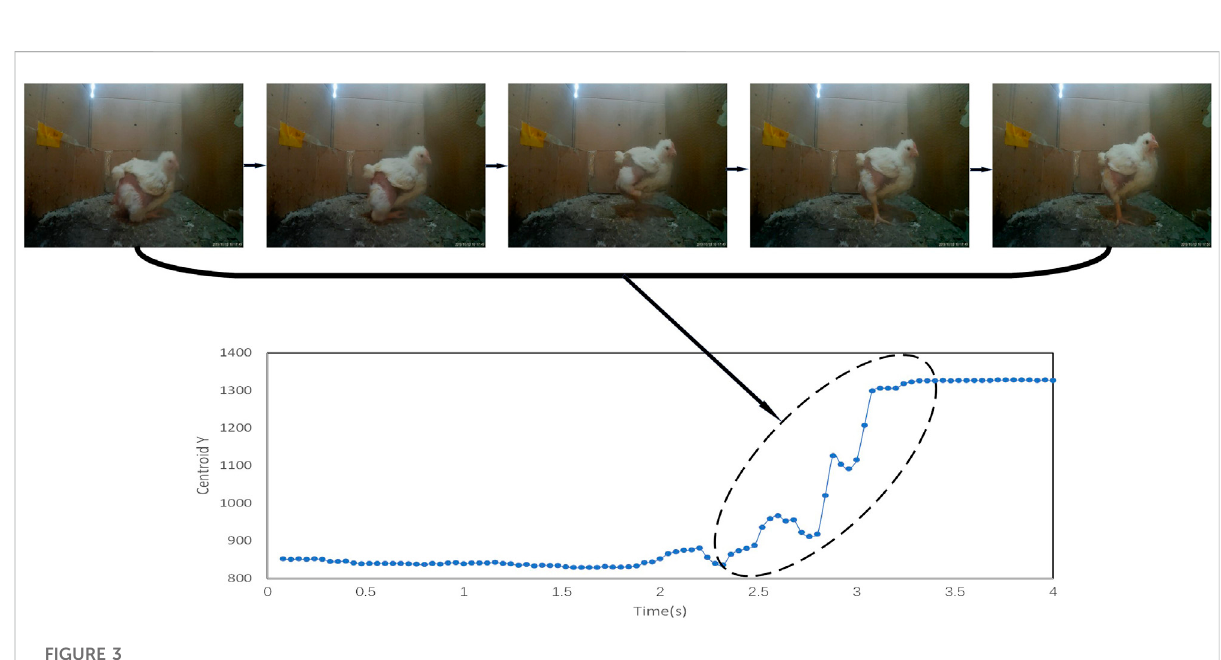
FIGURE 3 Posture conversion causes signal Centroid Y to